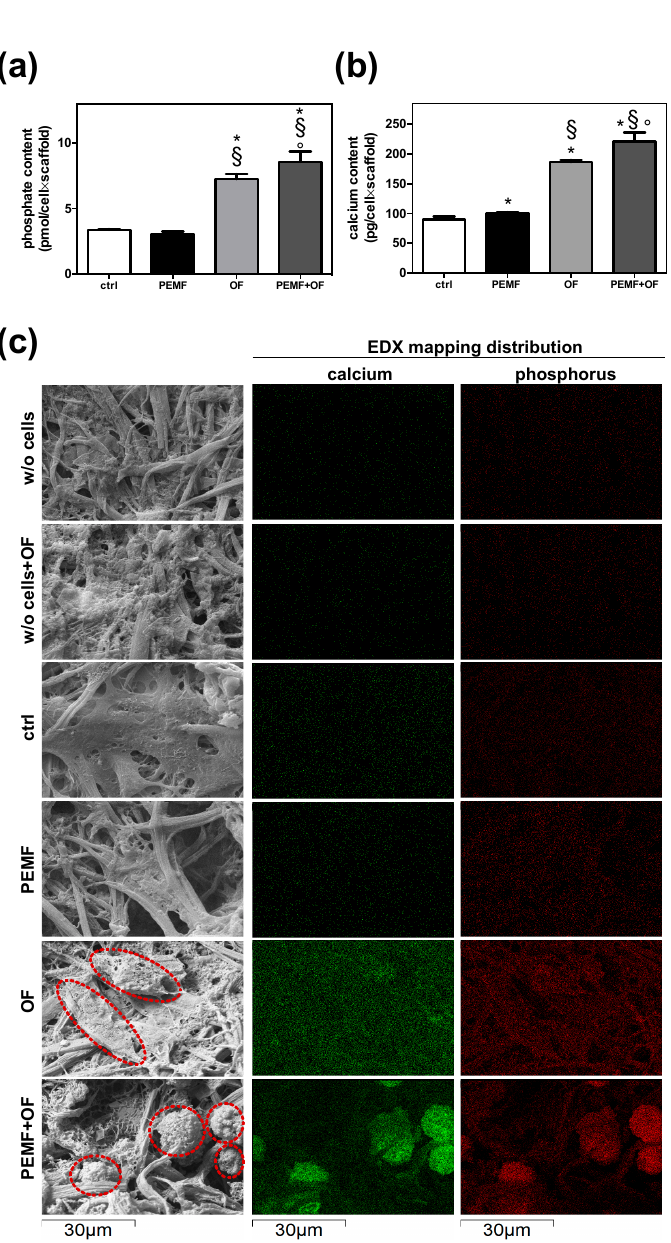
Figure 3. Quantification of inorganic matrix produced for 21 days. ( a ) Quantification of phosphate content by Phosphate Colorimetric Assay kit. Phosphate is measured in pmol / cell × sca ff old; results are presented as mean ± SD (N = 3; n = 2; symbols indicate statistical significance vs. control (*), vs. PEMF (§) and vs. OF ( ◦ )). ( b ) Quantification of calcium content by the Ca 2 + / o-cresolphthalein complexone method. Results are expressed as pg / cell × sca ff old and presented as mean ± SD (N = 3; n = 2, symbols indicate statistical significance vs. control (*), vs. PEMF (§) and vs. OF ( ◦ )). ( c ) Scanning Electron Microscopy with Energy Dispersive X-ray Spectroscopy (SEM-EDX) analysis of calcium and phosphorous deposits. Representative SEM pictures show the presence of inorganic deposits (indicated with red dotted circles) in particular in cells cultured in wool keratin sca ff olds and treated for 21 days with PEMF + OF. EDX elemental mapping of calcium (green) and phosphorus (red) relative to the SEM pictures (dimension: 64.68 × 43.12 µ m). All EDX analyses were conducted with an accelerating voltage of 20 kV and under low vacuum conditions. Wool keratin sca ff olds cultured in maintenance medium in absence of cells (w / o cells) and with OF (w / o cells + OF) for 21 days were included as control. In both these conditions, the calcium and phosphorus signals were negligible.